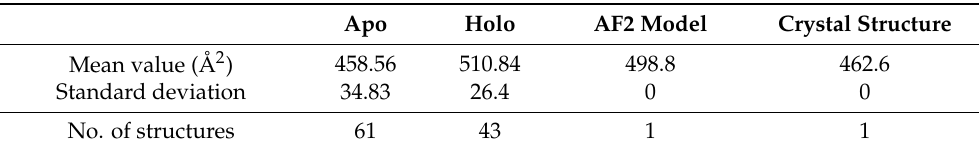
Figure 8. Comparison of the ligand binding capability with respect to both apo and holo templates that are used by AF2 for modeling the B318L protein. ( A ) Distribution of protein-ligand contact areas separated into apo and holo groups. ( B ) Distribution of pocket C α distances divided into apo and holo groups. The three horizontal dotted lines in each group from up to down indicate the 75th percentile value, median value, and 25th percentile value, respectively. Each dot represents a template structure. Table 3. Statistics of protein-ligand contact areas for apo and holo templates. The AF2 model and experimental structure are also shown for